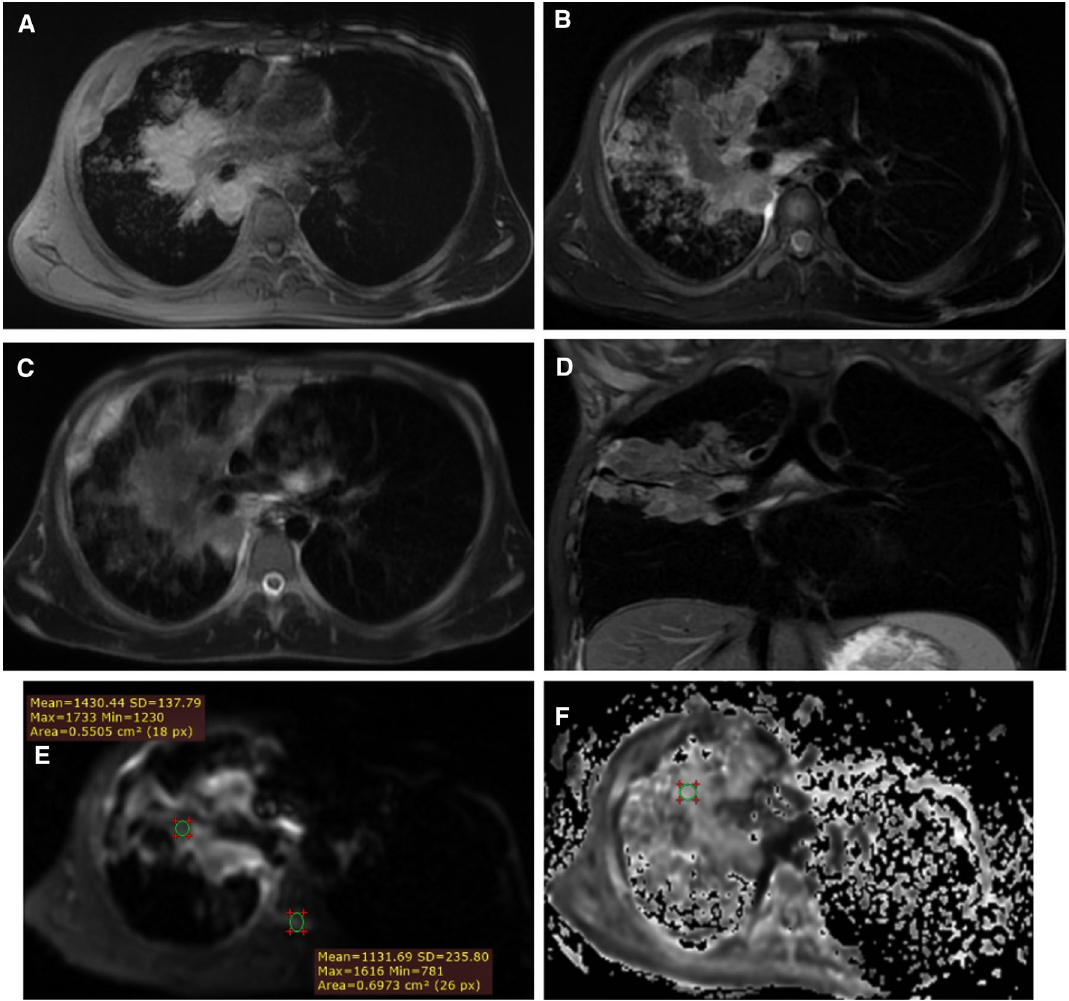
Fig. 5 Male patient 40‑years old presenting with fever, malaise and expectorations A‑D: Axial T1 ( A ), axial T2 ( B ), axial STIR ( C ), coronal STIR ( D ), = weighted MR images show right upper lobar consolidation with internal air bronchogram as well as surrounding tree in bud nodules. They elicit hyperintense T1 signal and mixed high/low signal intensity relative to the surrounding muscles. DWI ( E ) and ADC map ( F ) images show facilitated diffusion and LSR 1.26, ADC mean value 1.6 with ADC min value 1.42. Clinical and laboratory results of active pulmonary tuberculosis infection =